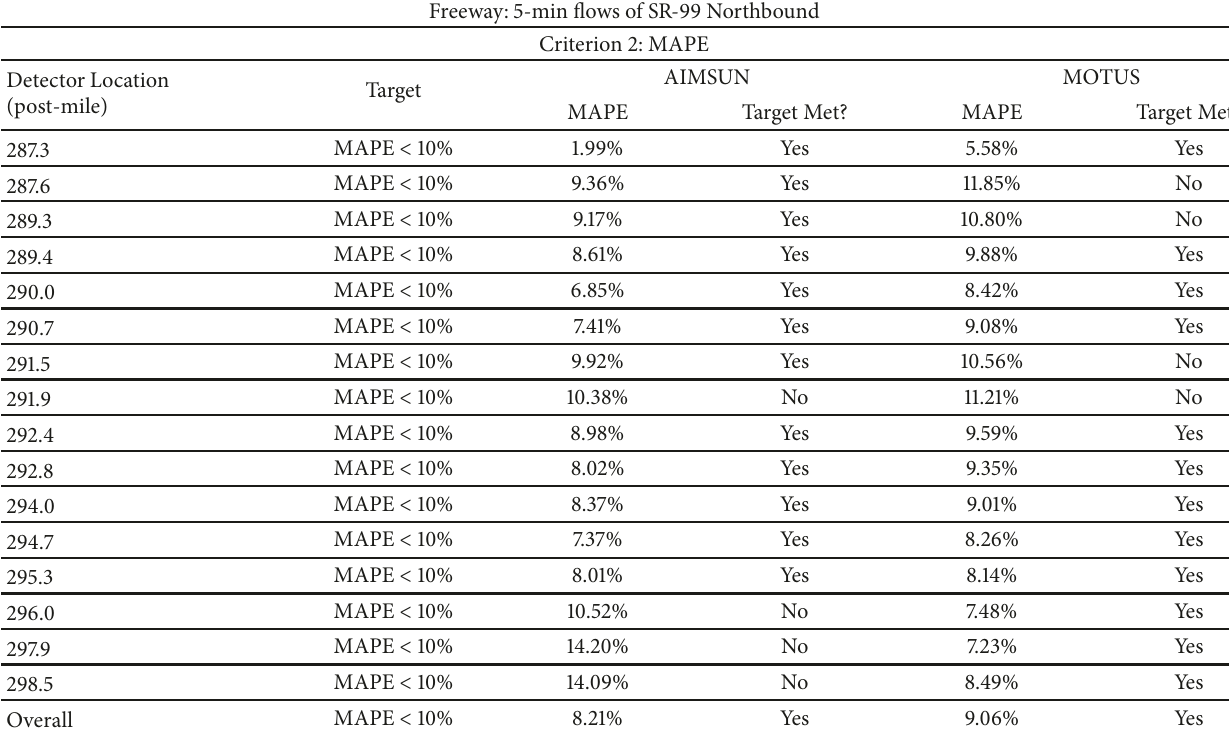
Table 4: Calibration of freeway flows under MAPE